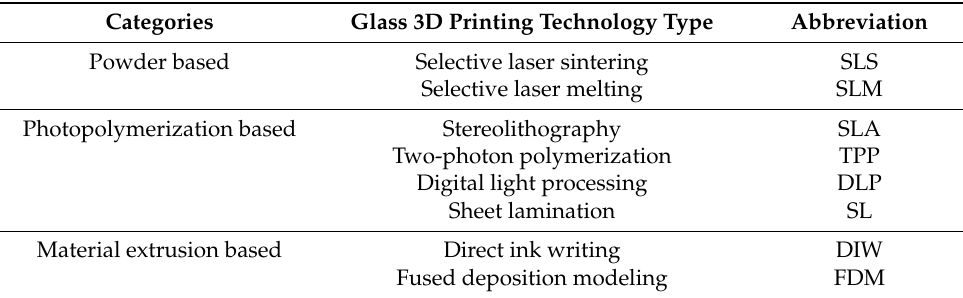
Table 1. Glass 3D printing